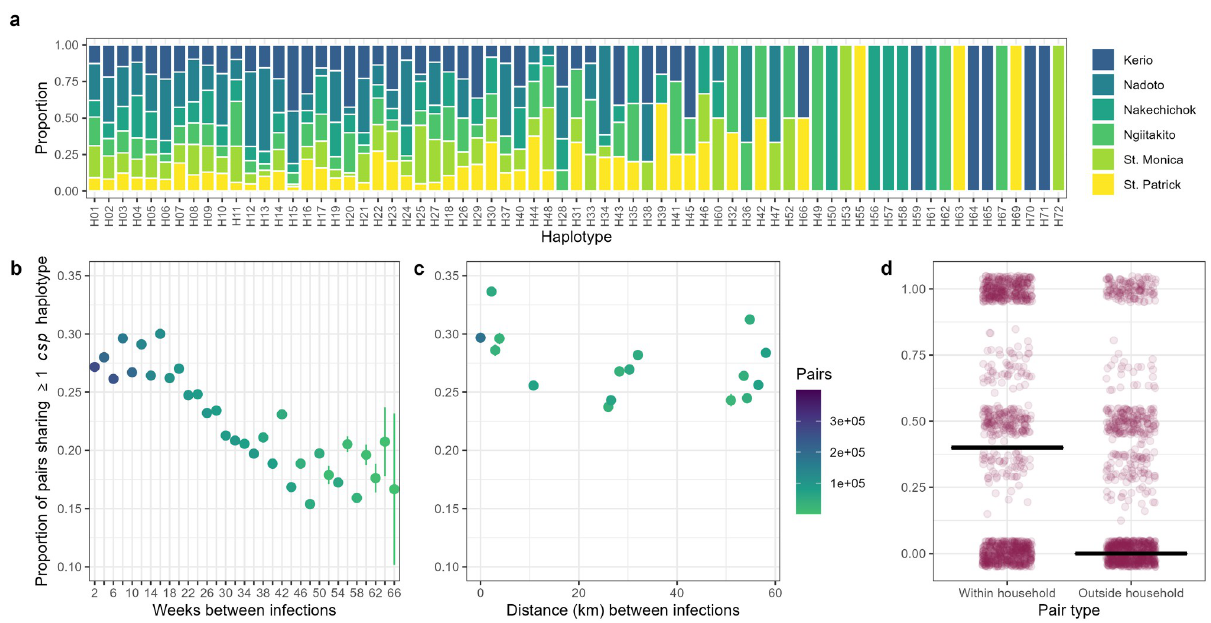
Fig 3. csp haplotype distribution and sharing in Central Turkana. (a) A majority of csp haplotypes were detected at multiple sites across Central Turkana. Columns are individual csp haplotypes, and colors indicate the proportion of samples harboring the haplotypes detected at each of 6 enrollment sites. (b) The proportion of infection pairs sharing at least one csp haplotype decreases with increasing time between infections. Each dot represents the proportion of all pairs separated by the indicated interval (with n = the color) that shared at least 1 csp haplotype. (c) A marginal decrease in the proportion of individuals sharing at least one csp haplotype with increasing distance (facility level) between infections was observed. Each dot represents the proportion of all pairs separated by the indicated geographic distance (n = the color) that shared at least 1 csp haplotype. (d) The median proportion of individuals sharing at least one haplotype was greater within the household than outside the household. Within household, each dot represents the proportion of household members with whom an individual shared at least one haplotype. Outside household, each dot represents the median proportion of subsampled (n = number of household members, reps = 1000) infection pairs outside the household within ± 60 days that share at least one